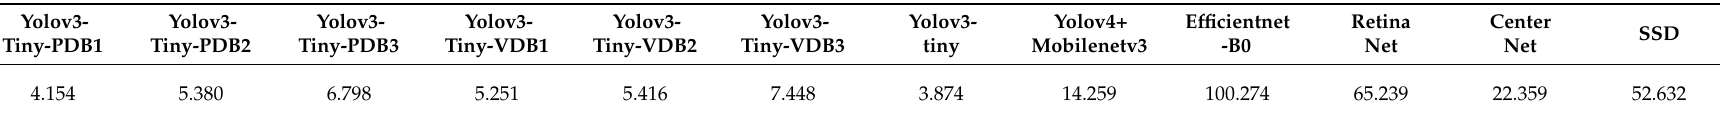
Table 6. Average processing time comparison using different deep learning